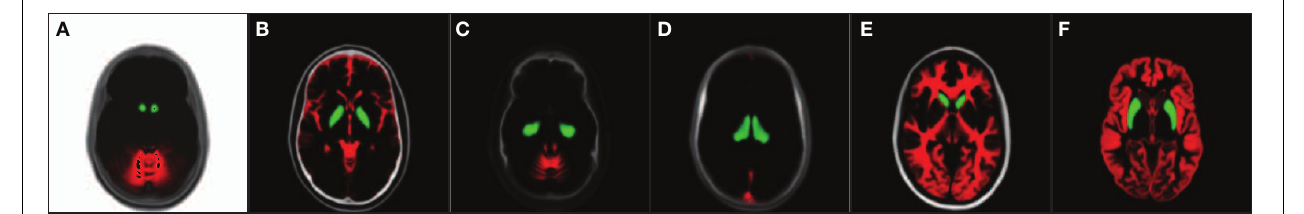
WM [r], (D) Not venous blood [gr], thalamus [gn], and venous blood [r], (E) Not WM [gr], caudate [gn], and cerebral WM [r], and (F) Putamen [gn] and surface cerebral GM [r].